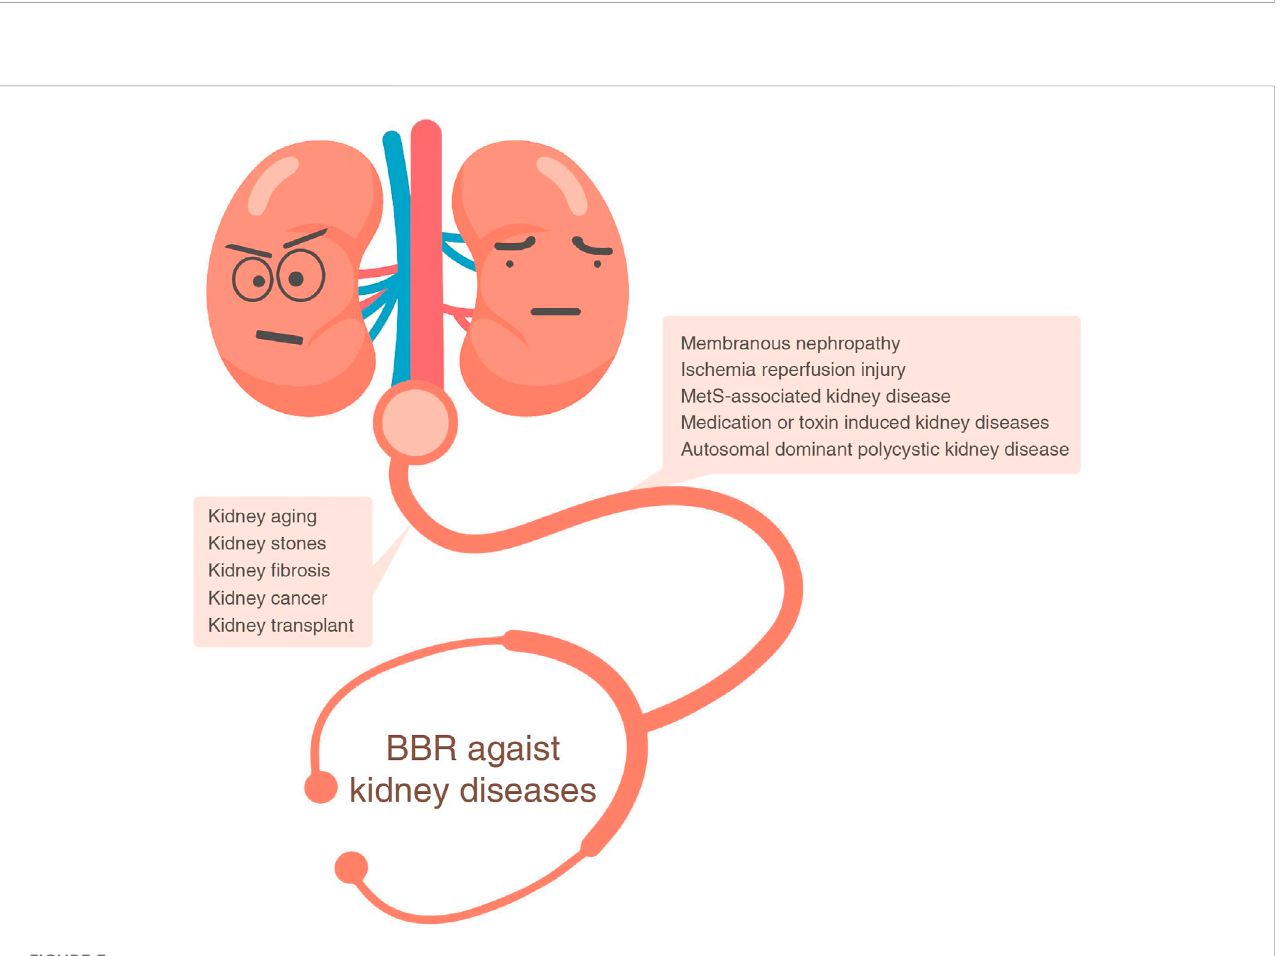
BBR against kidney diseases. BBR,